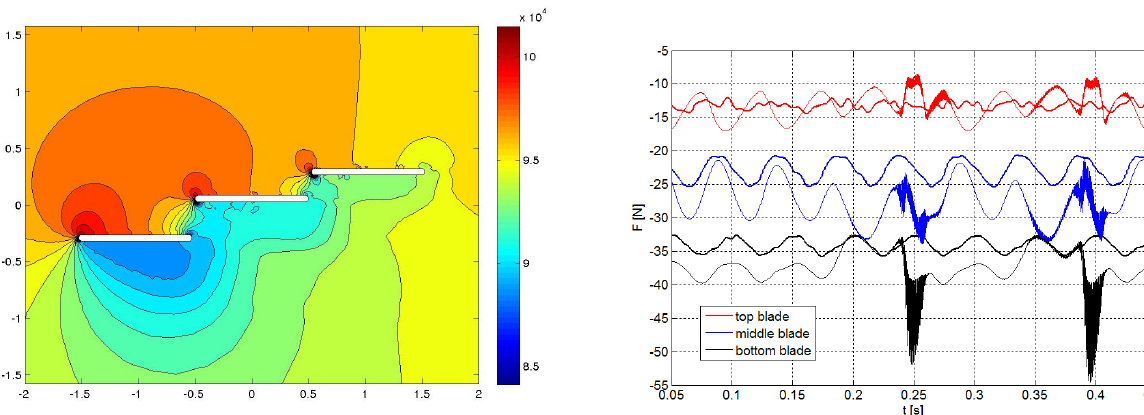
Fig. 2. Computational domain and triangular mesh. Fig. 5. Pressure contours at time t = 0 . 1109s, where the middle plate reaches a highest displacement.